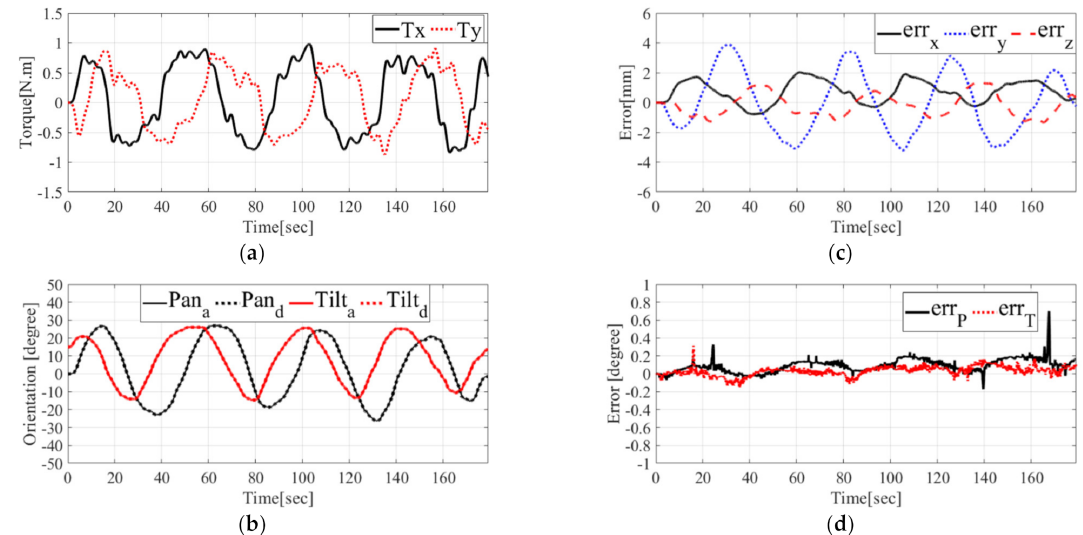
Figure 10. Experimental results in cone-shaped motion: ( a ) measured torque; ( b ) trajectory of desired and actual orientation; ( c ) position error of remote center; ( d ) orientation error of